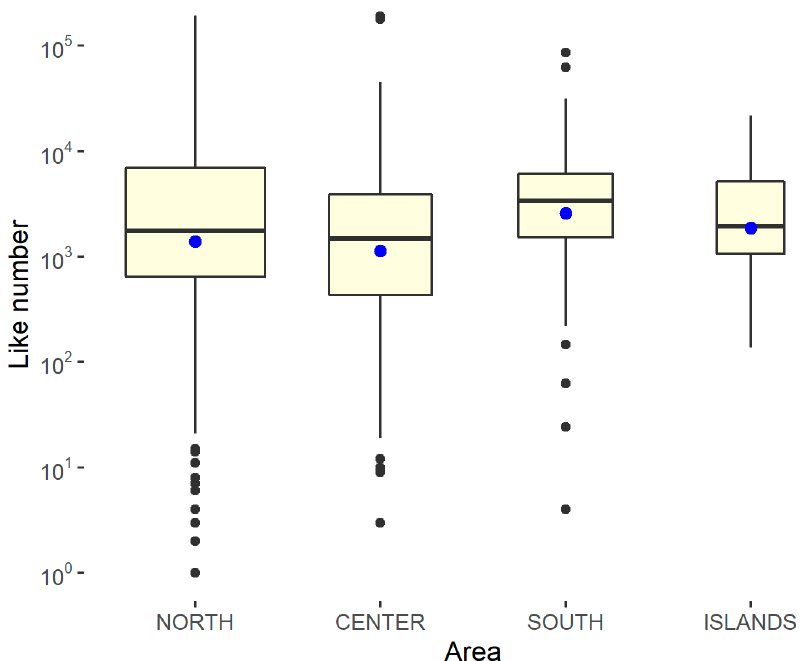
Figure 10. Kruskal–Wallis rank-sum test on the number of likes per area. Kruskal–Wallis chi-squared = 8.8093, df = 3, p -value = 0.031 (significant difference).